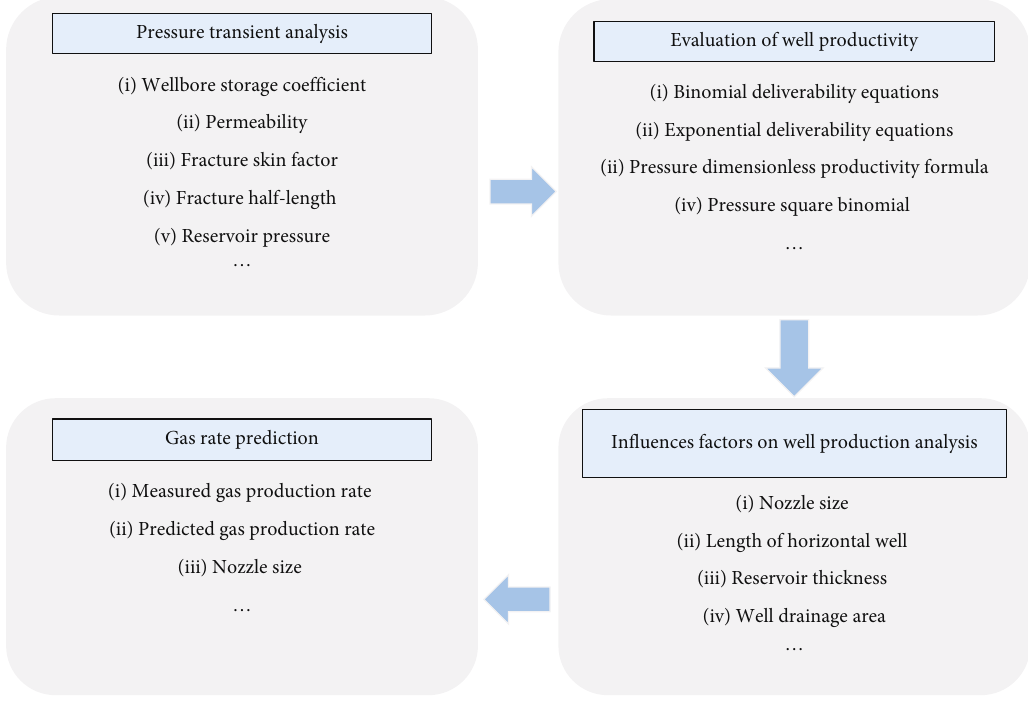
Figure 1: Work fl ow of the